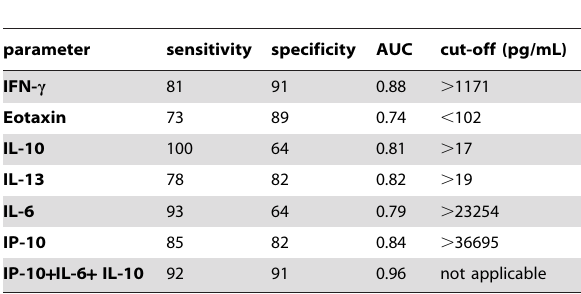
Table 3. Sensitivity and specificity of unstimulated pleural fluid cytokine